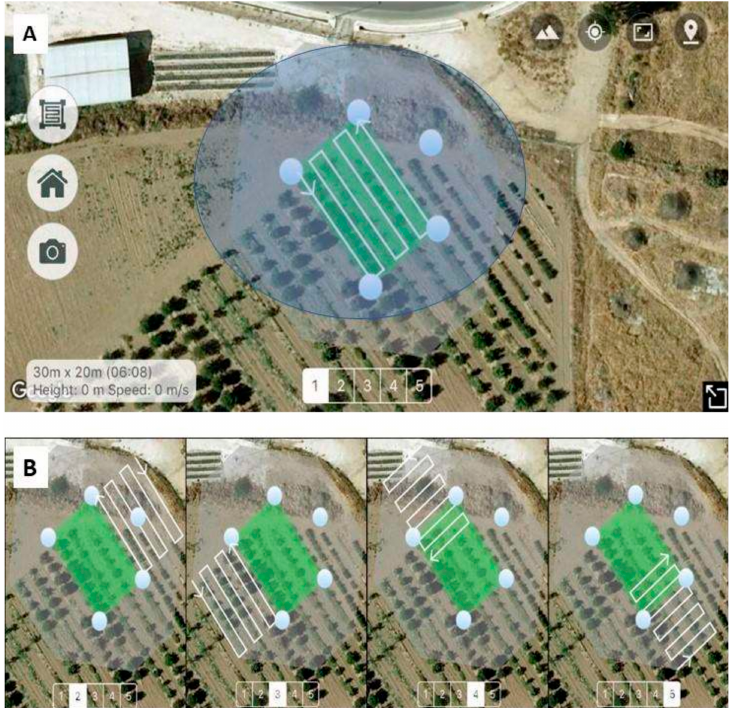
Figure 7. Unmanned aerial vehicle (UAV) paths: ( A ) Vertical flight; ( B ) Flights for oblique photographs. The plot to be flown has an area of 600 m 2 . This was covered with a photographic flight with UAV. For the 5-pass flight, the time needed to perform the flight was 30 min and 40 s. A total of 171 images were obtained. This program uses calculation algorithms based on SfM (Structure from Motion) techniques and performs a range of semi-automatic processes. The process was as follows: a dense point cloud was obtained, formed by a total of 2,691,196 points. With the 14 ground control points (GCP) the model was georeferenced. With these data, the software got an average error of 0.0393 m in coordinates with an accuracy of 0.005 m and with an error of 1.41 pixel. One process to take into account, due to its importance in the final result, is the orientation of the images based on the bundle adjustment, which allows the spatial relocation of both a series of coincident points between images and the positions of the cameras that took those images with respect to the